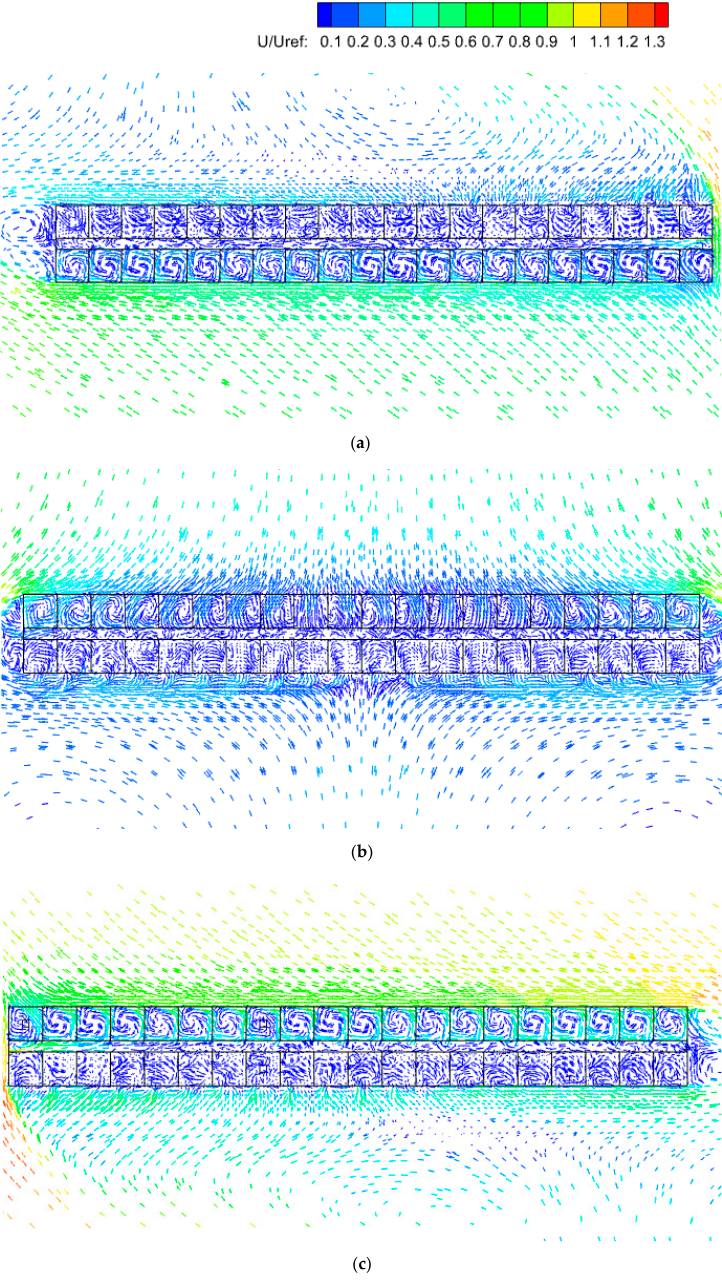
Figure 17. Vectors of mean velocity on horizontal planes around the building under three wind directions at a height of Z = 0.76 m. ( a ) Southeast wind. ( b ) North wind. ( c ) Northwest wind.